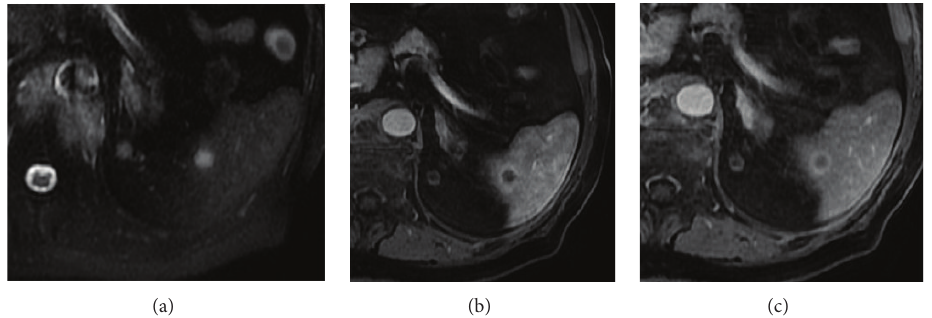
Figure 17: Splenic metastasis on a patient with a small-cell lung carcinoma. Axial T2wi SSFSE (a) and postcontrast axial 3D-GRE T1wi with fat suppression at the arterial (b) and venous (c) phases. Note the nodular lesion depicted as a hyperintense nodule on T2wi with peripheral ring-like enhancement.